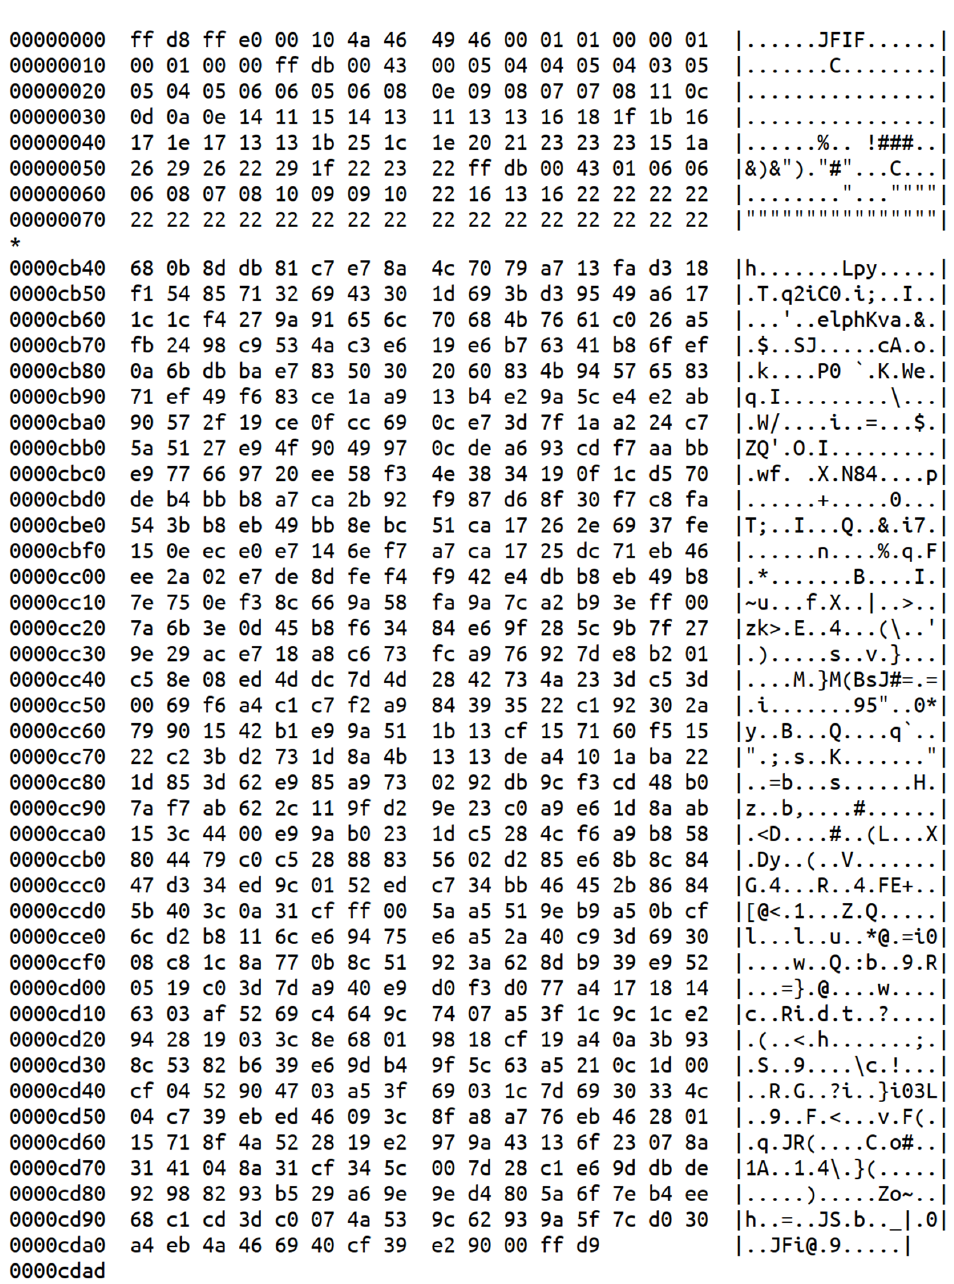
Figure 6. Hex dump of the image that contains a hidden block (begin and end).